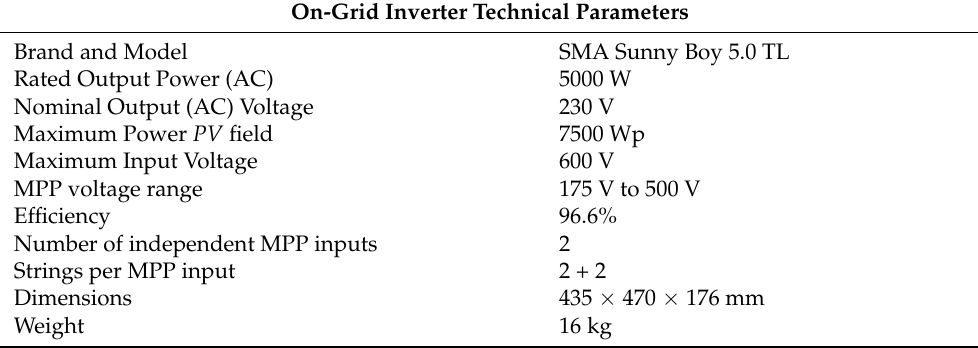
Table 2. Technical Parameters of the inverter.